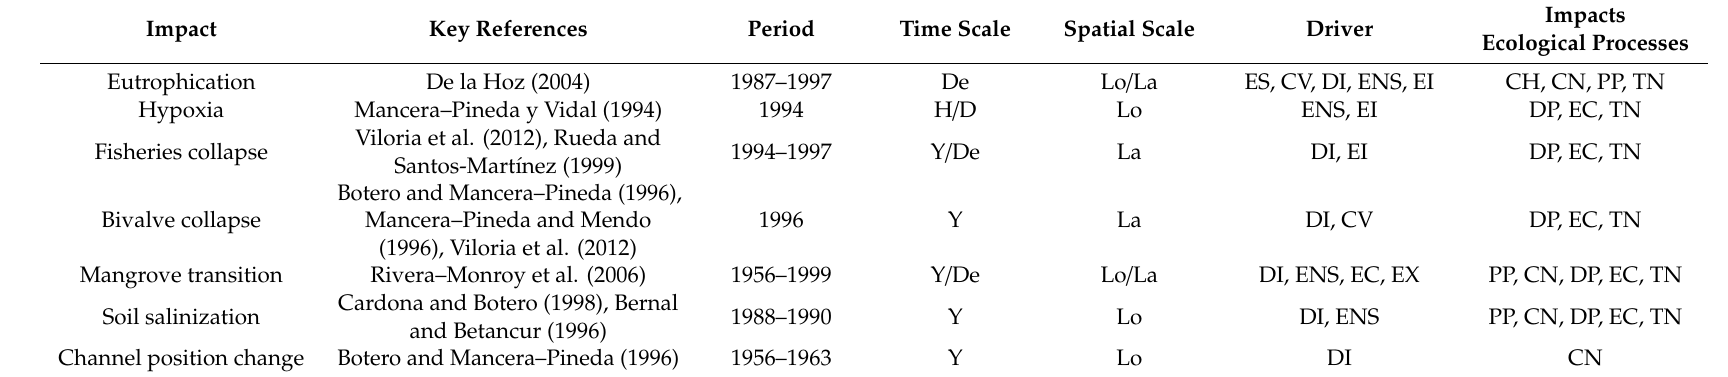
Table 1. Summary of the factors inducing ecological changes in the Ci é naga Grande lagoon